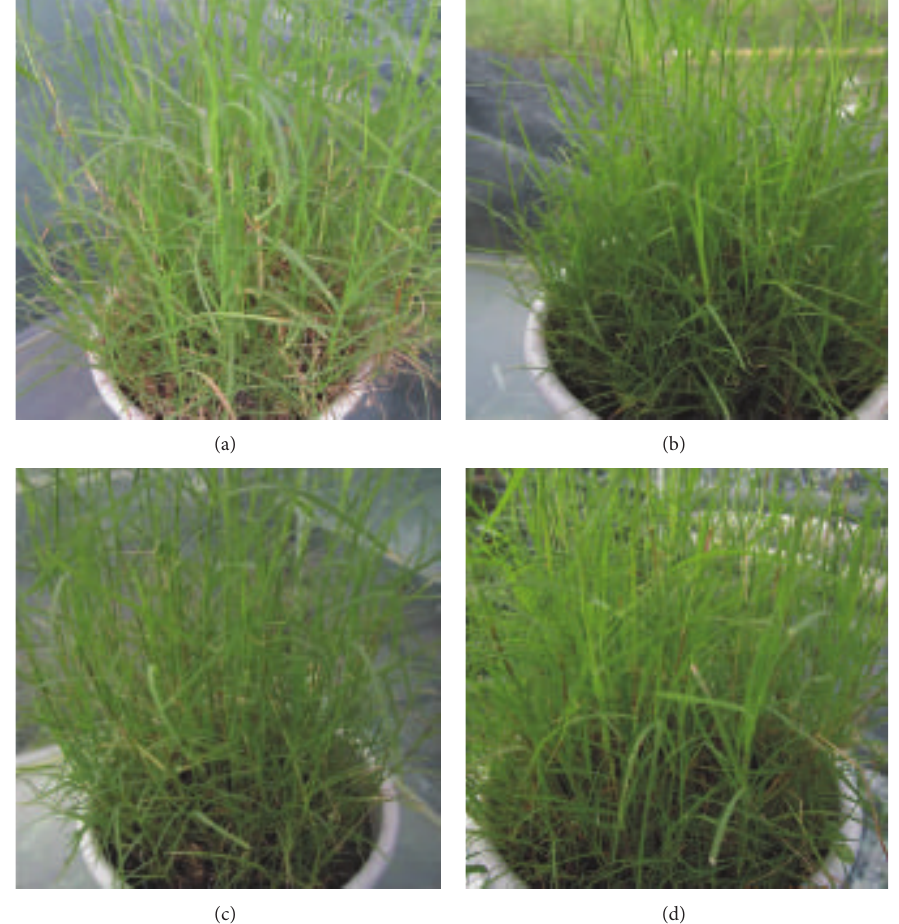
Figure 2: Symptoms of C. dactylon accessions in response to SO 2 . (a) SO 2 -sensitive representative C. dactylon accession CQ1116, (b) intermediate SO 2 -tolerant representative C. dactylon accession SC1217, (c) high SO 2 -tolerant representative C. dactylon accession SC1203, and (d) C. dactylon accession CQ1116 without SO 2 treatment as a